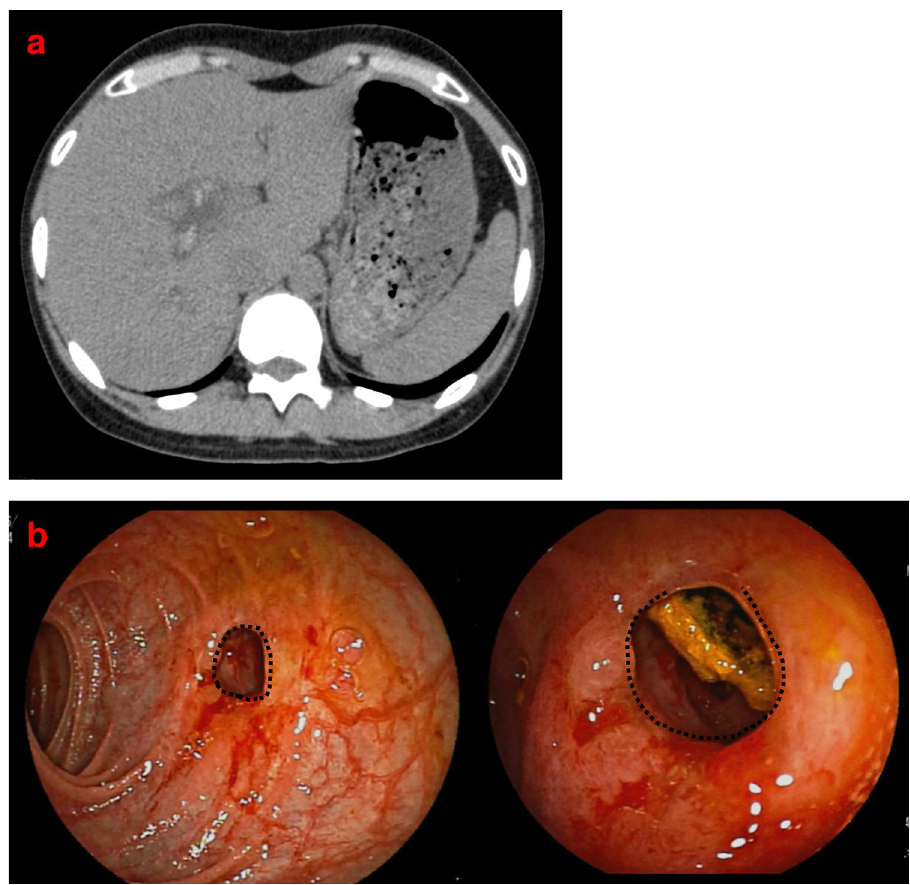
Figure 2. Case 3 from Table 4. ( a ) Stones are identified on computed tomography twelve years after radical surgery. ( b ) An anastomotic stricture was identified using DBERC. (dotted line) Balloon dilation and lithectomy were performed. DBERC double-balloon endoscopic retrograde